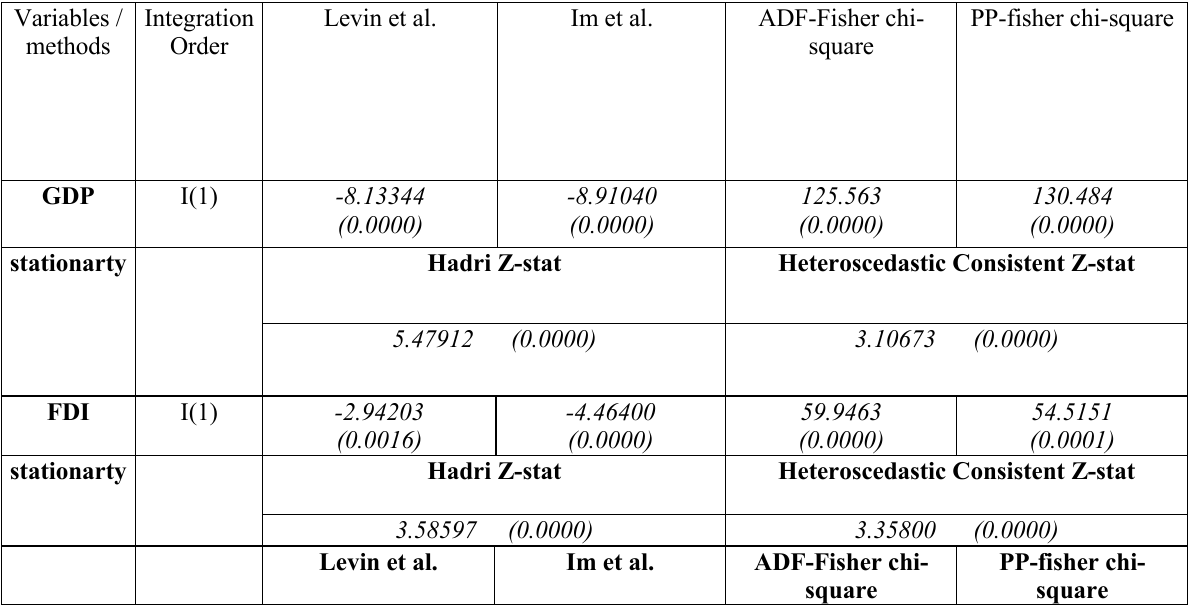
Table 2. Unit root test